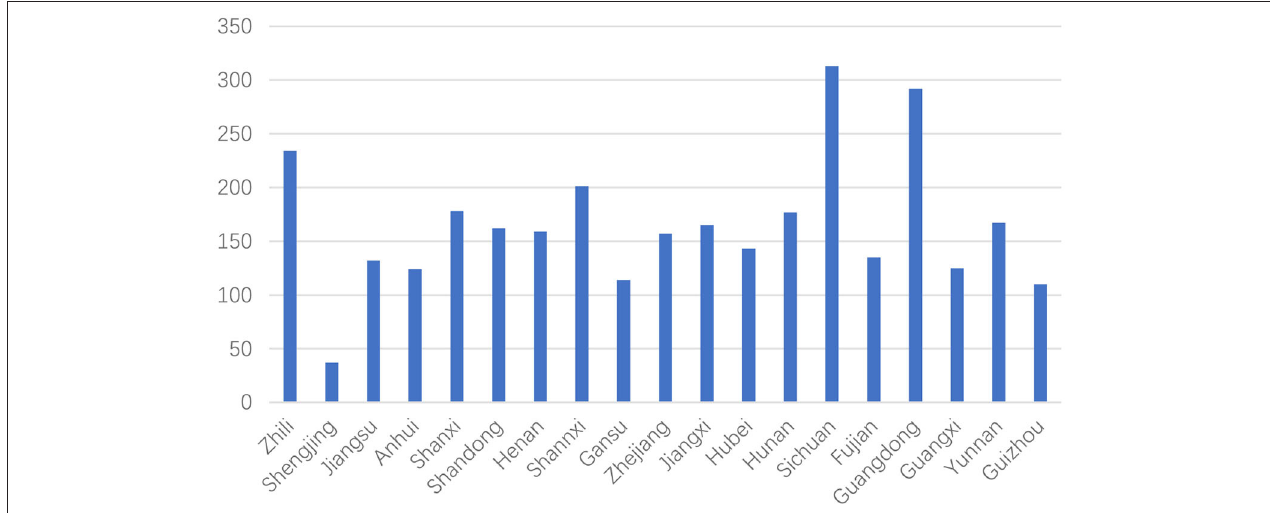
FIGURE 1 | Number of Confucian schools in the provinces of the Qing Dynasty. This figure plots the number of Confucian schools in the provinces of the Qing Dynasty. The horizontal axis represents the provinces, and the vertical axis represents the number of Confucian